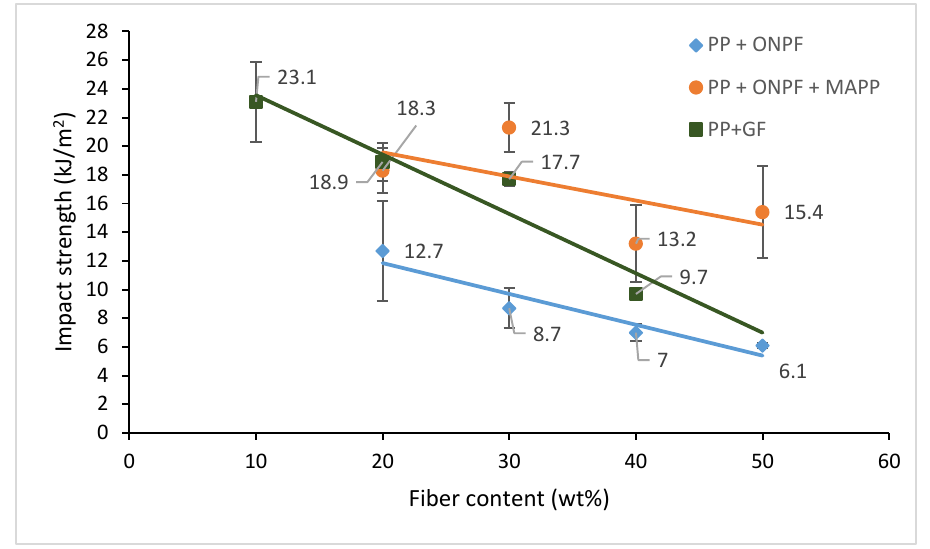
Figure 3. Charpy impact strength evolution regarding fiber content for uncoupled and coupled polypropylene (PP) + old newspaper (ONPF) and coupled PP + GF composites. 223